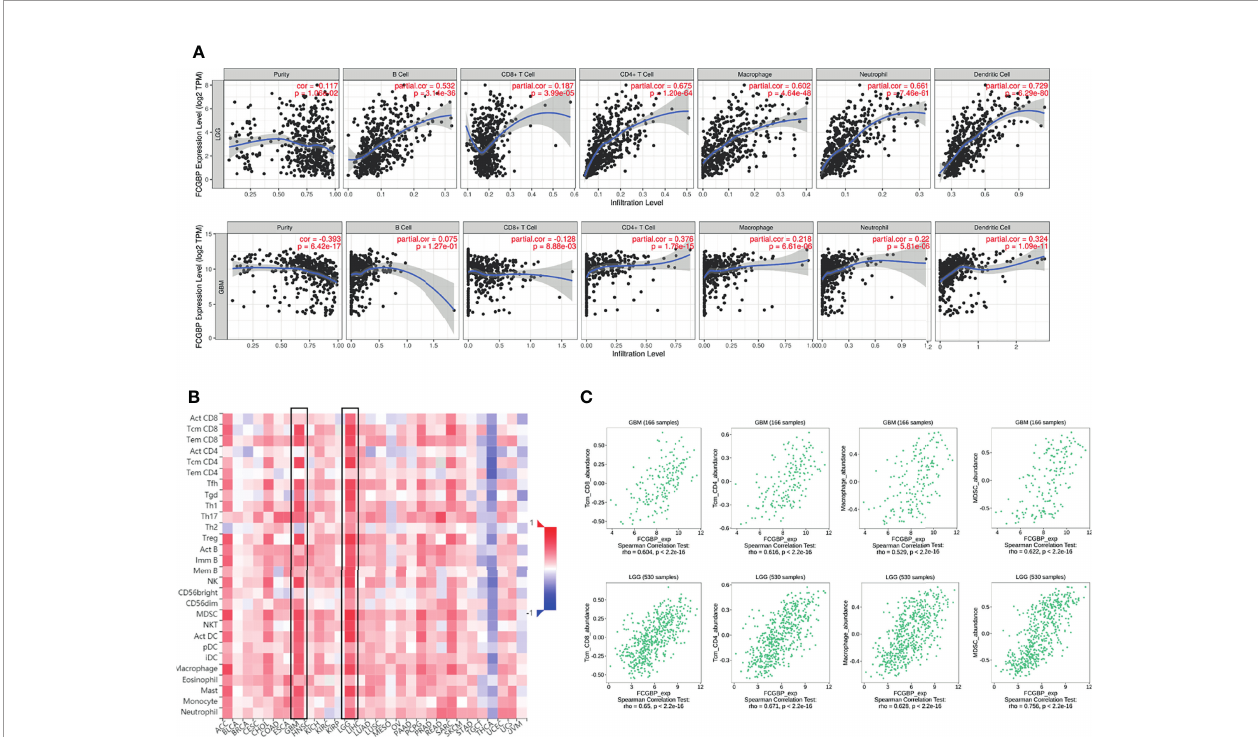
FIGURE 6 | The relationship between the expression of FCGBP and the level of immune in fi ltration in glioma. (A) The expression of FCGBP is correlated with the level of tumor immune in fi ltration of B cells, CD8 + T cells, CD4 + T cells, Neutrophil and Dendritic cells in glioma. (B) Correlations between FCGBP expression and immune in fi ltration levels in TISIDB. (C) The relationship between the expression of FCGBP and CD8 + T cells, effector memory CD4 T cells, Myeloid-derived suppressor cells, macrophages in